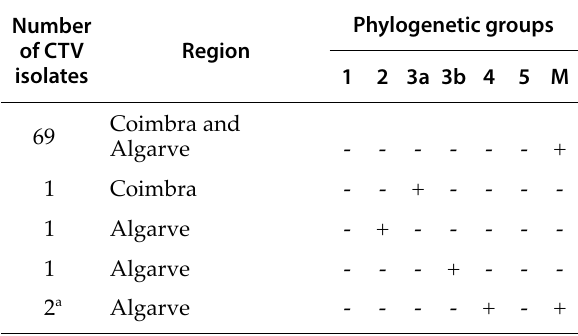
Table 2. APET results for CTV isolates obtained in the pe- riod 2009-2011. Phylogenetic Number of CTV Region isolates